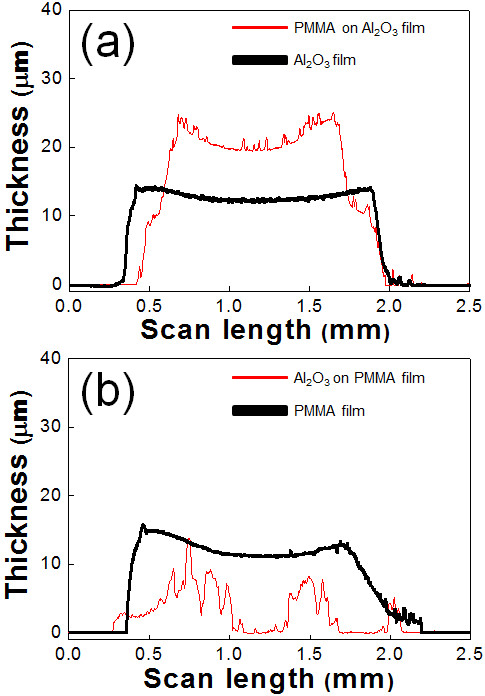
The thickness of the (a) PMMA on Al2O3films and (b) Al2O3on PMMA films.